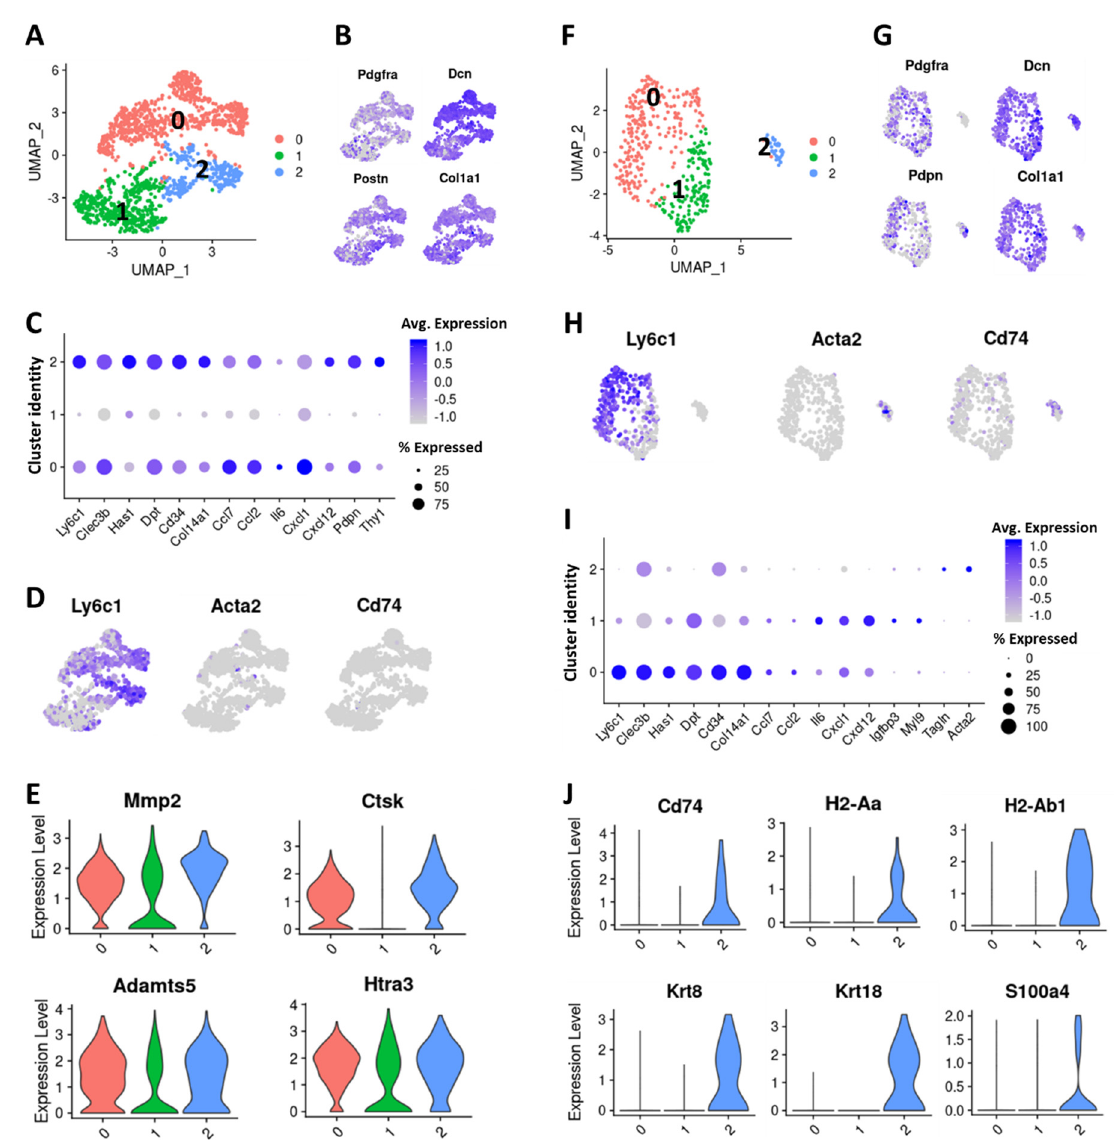
Figure 5. Characterization of normal tissue-resident fibroblasts. ( A ) UMAP plot showing various fibroblast subtypes identified in normal mammary fat pad. ( B ) Expression of commonly used fibroblast / CAF markers in mammary fat pad-derived fibroblast subtypes ( C ) Dot plot showing the expression of selected iCAF markers in mammary fat pad-derived fibroblast subtypes. Dot size represents the fraction of cells expressing a specific marker in a particular cluster and intensity of color indicates the average expression in that cluster. ( D ) Feature plot showing the expression of Ly6c1 , Acta2 and Cd74 in mammary fat pad-derived fibroblasts. ( E ) Violin plot showing the expression of matrix degrading enzymes in mammary fat pad-derived fibroblast subtypes (cluster identity on X-axis). ( F ) UMAP plot showing various fibroblast subtypes identified in normal pancreas. ( G ) Expression of commonly used fibroblast / CAF markers in normal pancreas-derived fibroblasts. ( H ) Feature plot showing the expression of Ly6c1 , Acta2 and Cd74 in pancreas-derived fibroblasts. ( I ) Dot plot showing the expression of selected iCAF markers in pancreas-derived fibroblast subtypes Dot size represents the fraction of cells expressing a specific marker in a particular cluster and intensity of color indicates the average expression in that cluster. ( J ) Violin plots showing the expression of Cd74 high CAF (apCAFs) markers in pancreas-derived fibroblasts